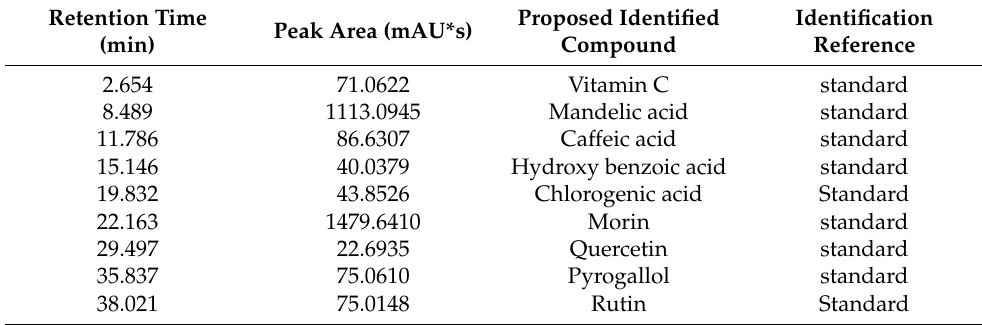
Table 2. Phenolic compounds identified by HPLC profiling of E. wallichii leaf extract.